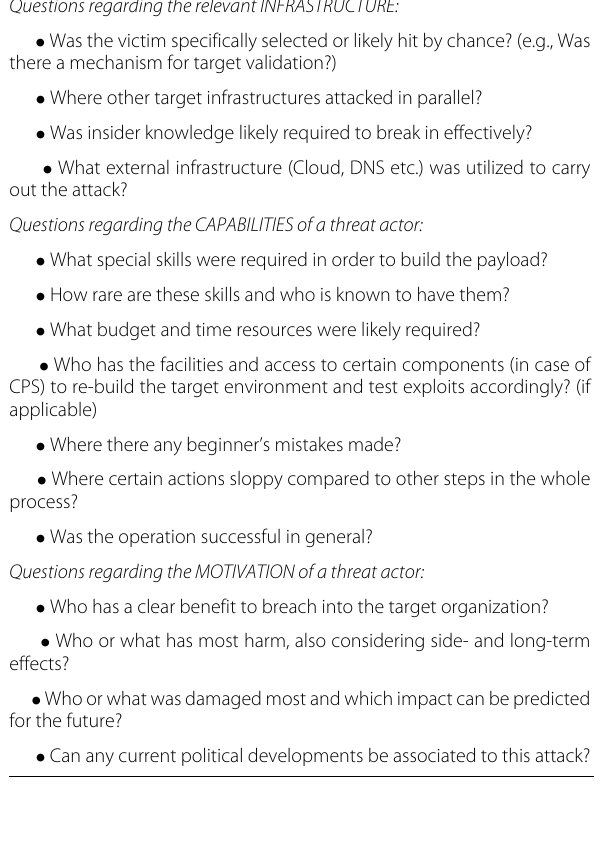
Table 2 Characterizing threat actors based on gained